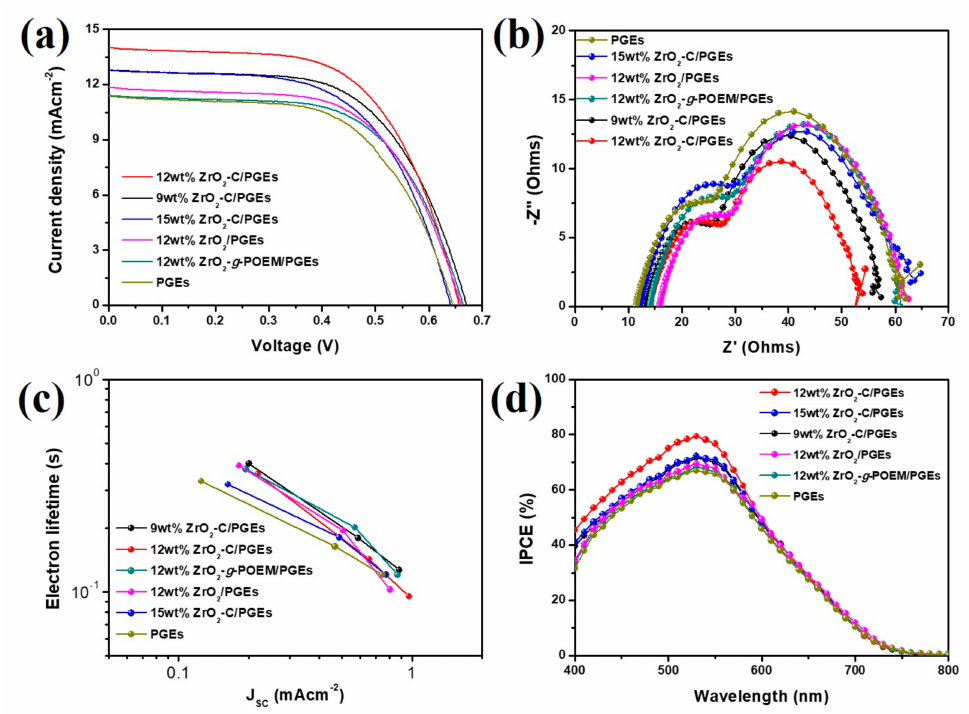
Figure 4. ( a ) J-V curves, ( b ) EIS Nyquist plots, ( c ) IMVS, and ( d ) IPCE of DSSCs fabricated with ZrO 2 -C / PGEs that were obtained under one sun illumination (AM 1.5, 100 mW cm − 2 ). Table 1. Photovoltaic and electrochemical parameters of DSSCs fabricated with ZrO 2 -C / PGEs that were obtained under one sun illumination (AM 1.5, 100 mW cm − 2 ).